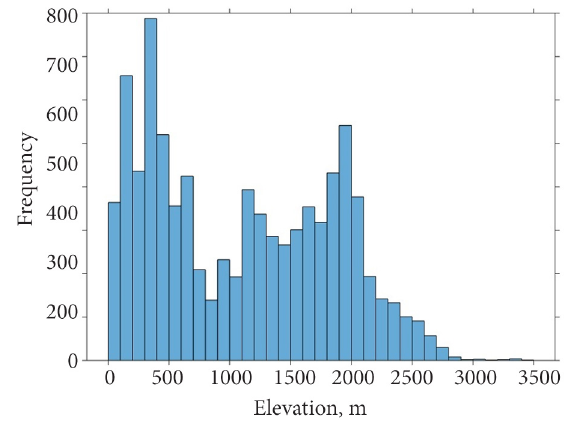
Figure 2. Elevation of gravity data over